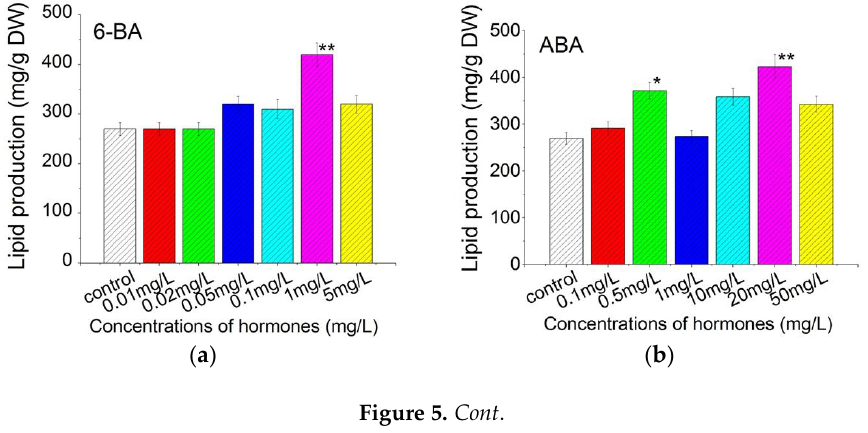
18.5 mg·g −1 ), 0.5 mg·L −1 (390.7 ± 19.3 mg·g −1 ), 10 mg·L −1 (389.6 ± 18.7 mg·g −1 ), and 20 mg·L −1 (470.5 ±